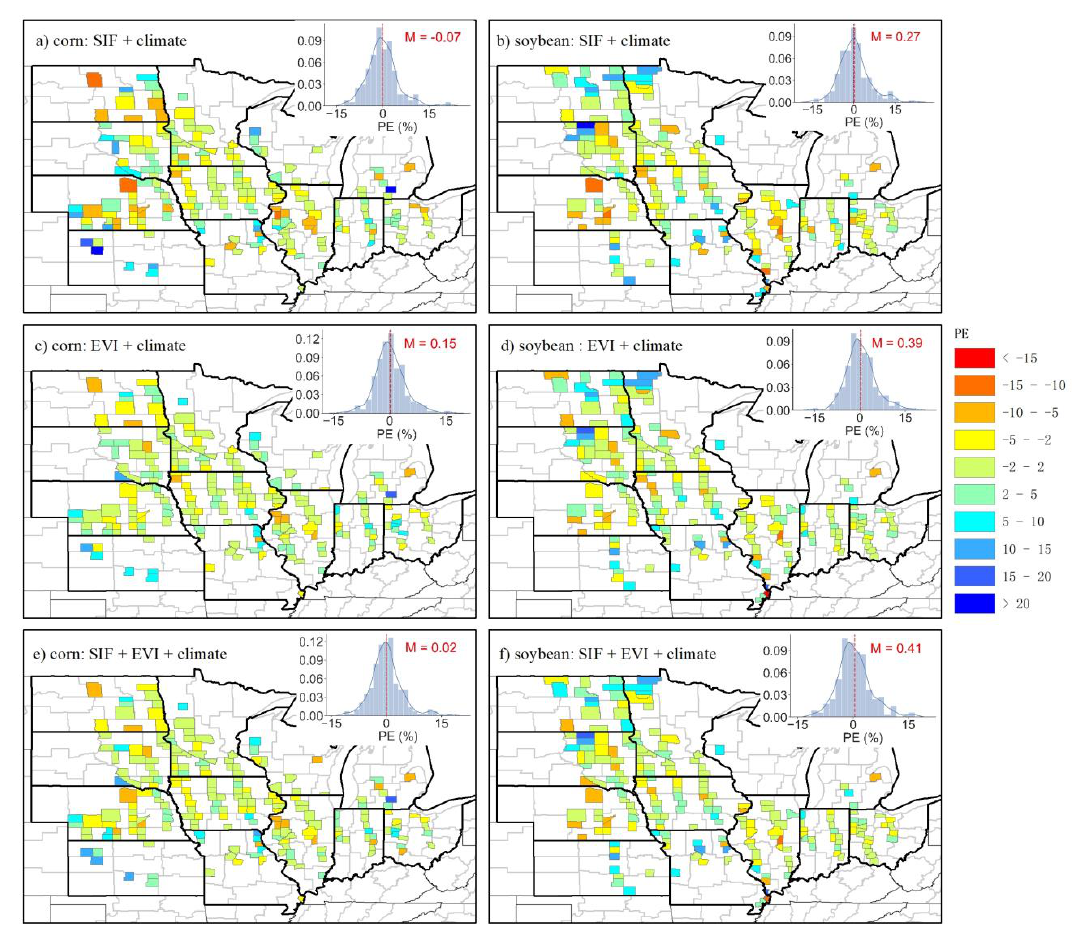
Figure 5. Spatial distribution of percentage error (PE) of county-level corn and soybean yields estimated by models using both satellite and climate predictors. Left panels are the maps for the corn, and right are for the soybean. The figure includes results from models that input both SIF and climate data ( a , b ), input both EVI and climate data ( c , d ), and input SIF, EVI, and climate data ( e , f ). In each plot, the density plot in the upright corner presents the overall distribution of PE. The red dashed lines and ‘M’ in the density plots represent the mean values of PE, and the black ones are the referenced lines located at zero. Positive values mean that estimated yields were lower than census data, vice versa.